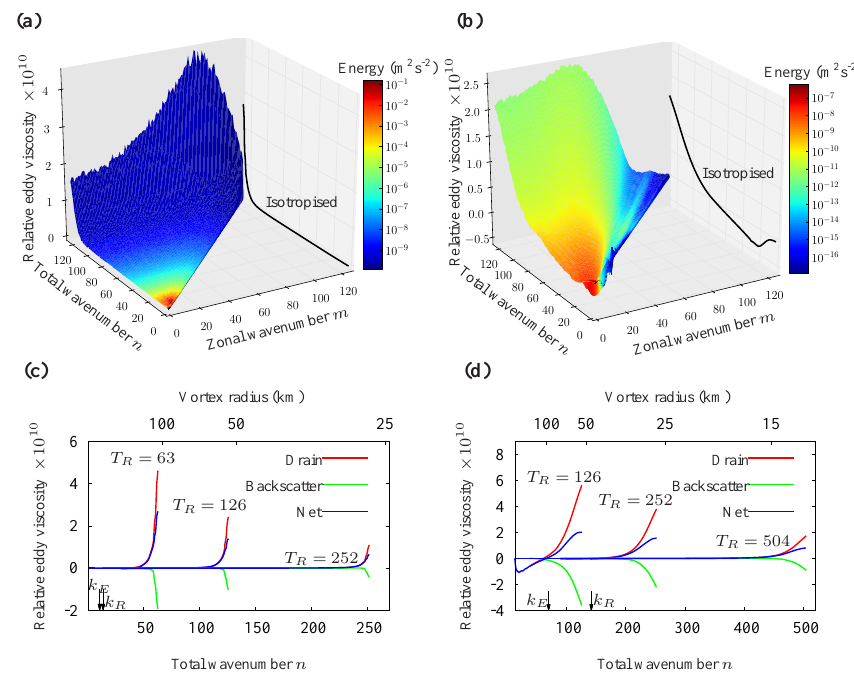
Figure 3. Real component of the upper diagonal subgrid eddy viscosities. Anisotropic drain eddy viscosity at T R = 126 for the (a) atmo- sphere, divided by the kinematic viscosity of air (10 − 5 m 2 s − 1 ); and (b) ocean, divided by the kinematic viscosity of sea water (10 − 6 m 2 s − 1 ). Coloured surfaces depict kinetic energy of the fluctuations at the upper level, and the black lines are the isotropised ( m -averaged) drain coef- ficients. Isotropic drain, backscatter, and net eddy viscosities labelled by T R for the (c) atmosphere and (d) ocean; with Rossby wavenumber ( k R ) and energy-containing wavenumber ( k E ) labelled on the horizontal